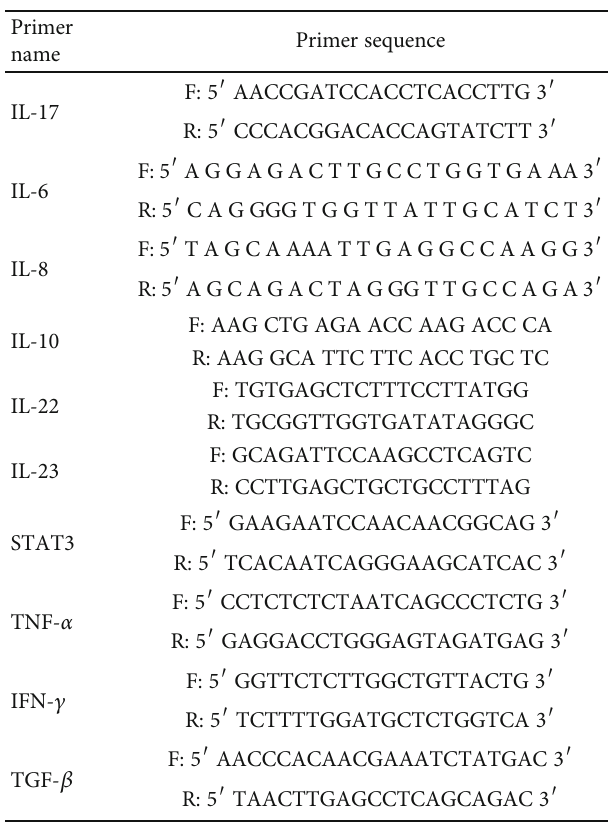
Table 1: Primer sequences used for quantitative real-time polymerase chain